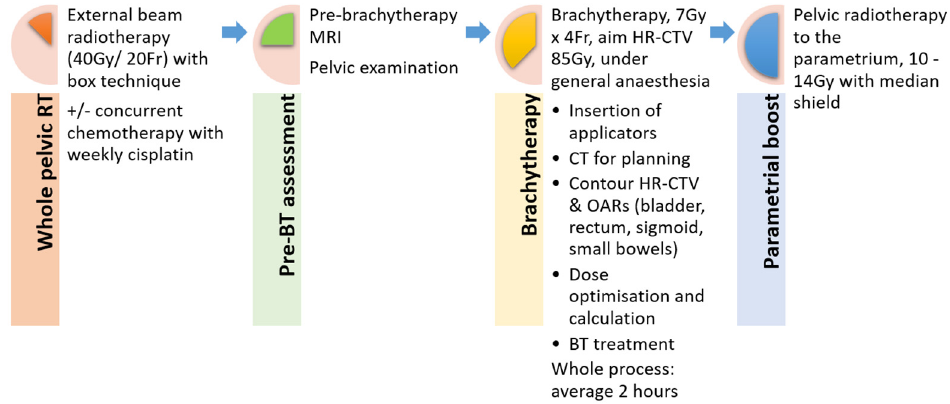
Figure 1. Workflow of chemo-radiotherapy for cervical cancer (whole pelvic radiotherapy then reassessment with MRI, followed by brachytherapy and external beam radiotherapy for parametrial boost).